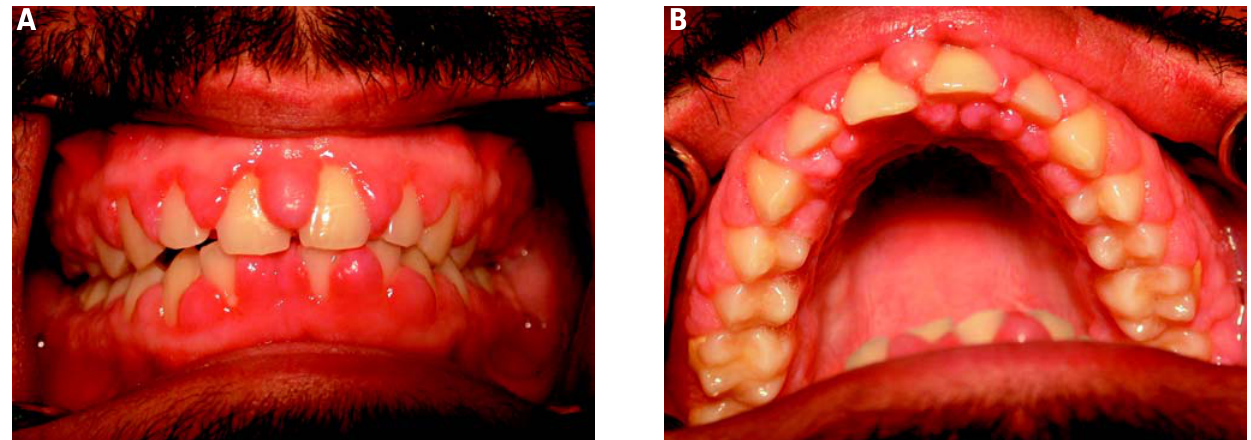
FIGURE 1- Gingival enlargement affecting the buccal (A) and palatal (B) surfaces of all